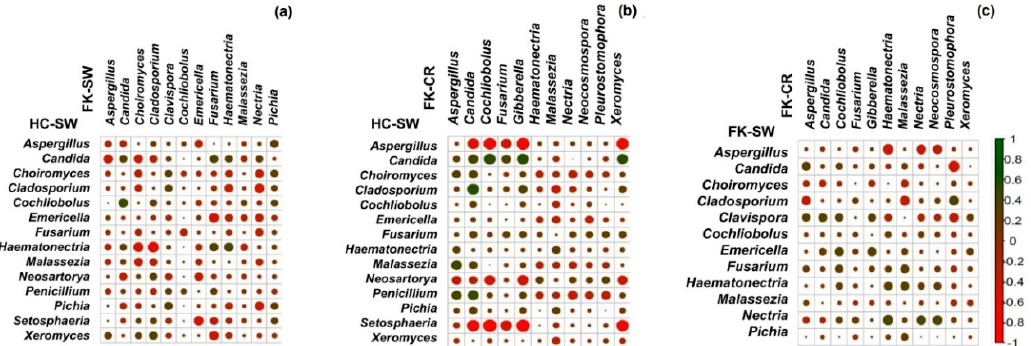
Figure 8. Correlation analysis (Spearman correlation) of fungal genera having a median abundance of > 0.0001% in the microbiome of conjunctiva of healthy individuals (HC-SW) and fungal keratitis patients (FK-SW) ( a ), microbiome of conjunctiva of healthy individuals (HC-SW) and cornea of fungal keratitis patients (FK-CR) ( b ), and microbiome of conjunctiva (FK-SW) and cornea (FK-CR) of fungal keratitis patients ( c ) .